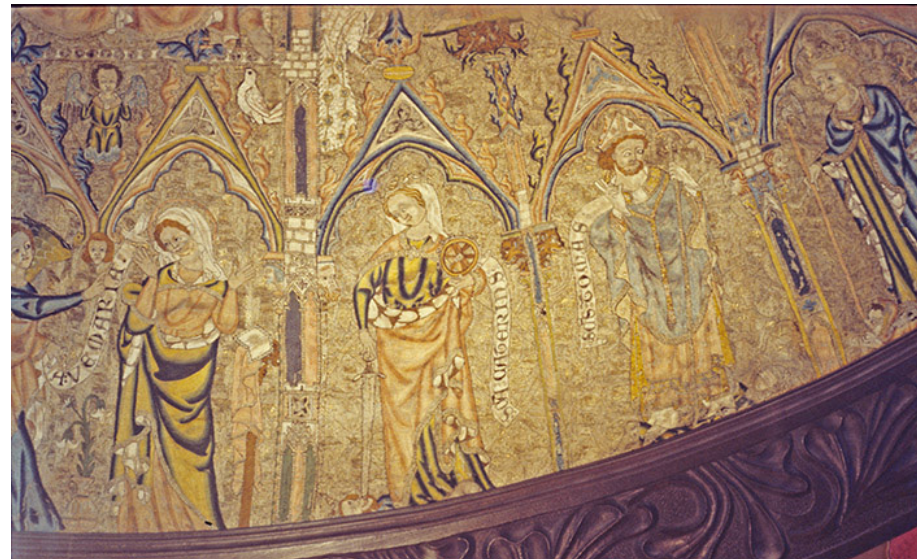
Figure 20. Toledo Cope, 1320–1330, detail: full-length representation of Thomas Becket. Toledo, Treasury of the Cathedral, Spain © Index of Medieval Art, Princeton.